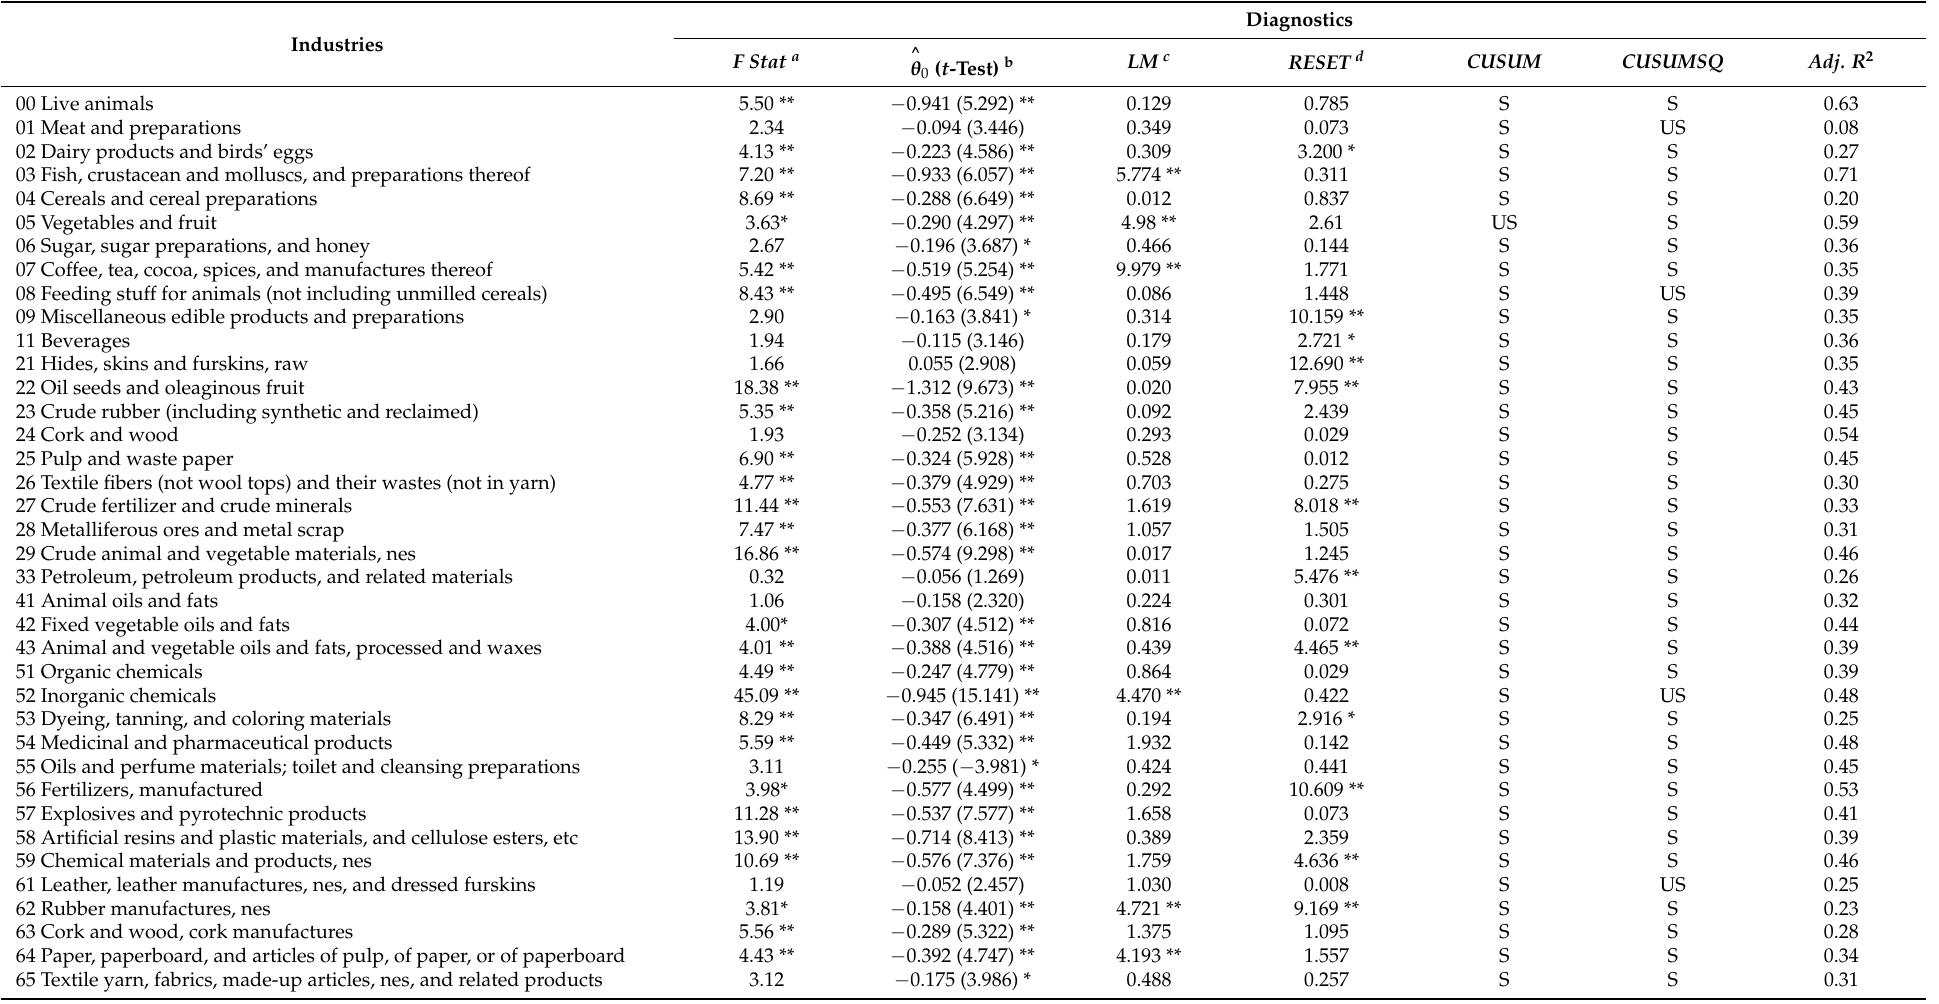
Table 4. Diagnostic statistics associated with U.S. export